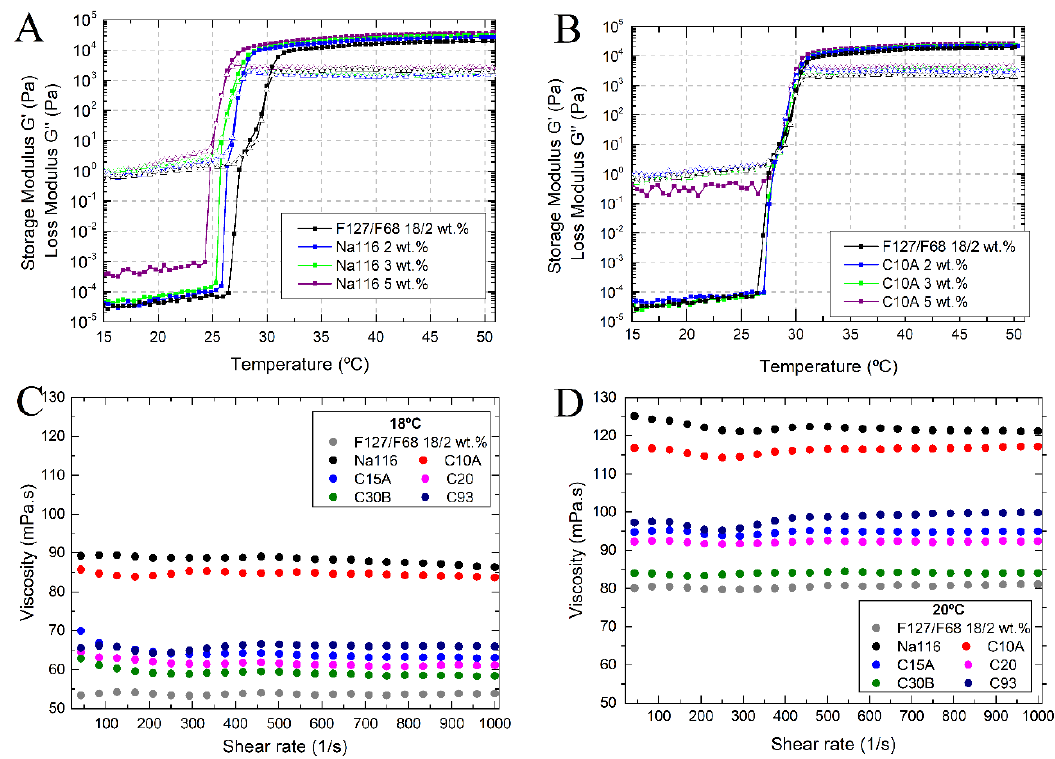
Figure 6. Viscoelastic behavior of Pluronic–clay composites, with Na116 ( A ) and C10A ( B ) clay concentration of 5, 3, and 2 wt.%, as a function of temperature. ( C , D ) Viscosity/Flowability curves of Pluronic–clay composites, with clay concentration at 2 wt.%, as a function of shear rate, at temperatures of 18 ◦ C and 20 ◦ C, respectively. Table 3. Pluronic–clay composite’s rheological data. G’ and G” at 37 ◦ C (gel state). Clay